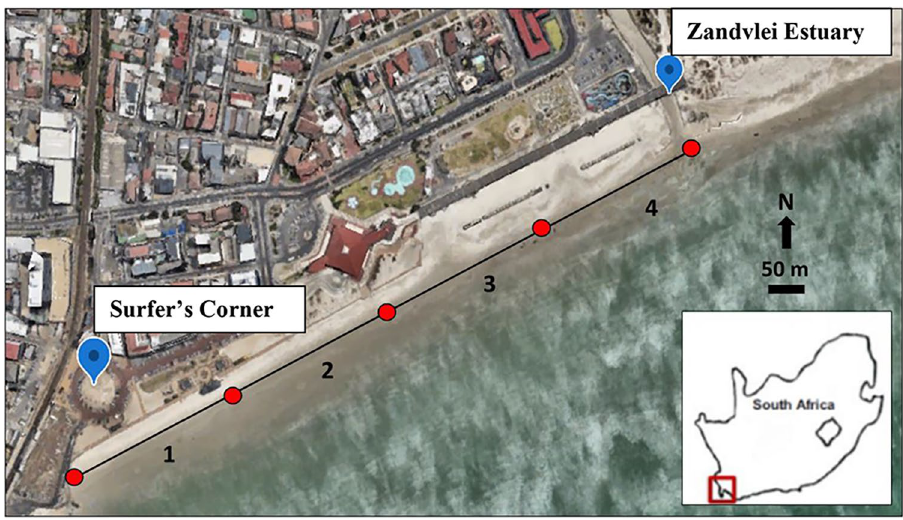
Figure 2. Google Earth image showing a 764 m stretch of Muizenberg beach (black line) from Surfers Corner to the Zandvlei Estuary mouth, including the four spatial zones (191 m each) used for the in situ survey under lockdown levels 3, 2 and 1. Inset: position of Muizenberg Beach within South